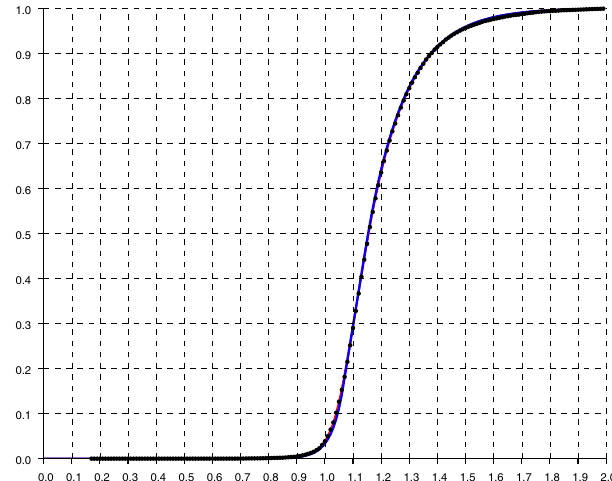
Figure 16. Normalized cumulative histogram of the ratio of reported to actual distance. The solid blue line is the “double exponential” with flat top parametric